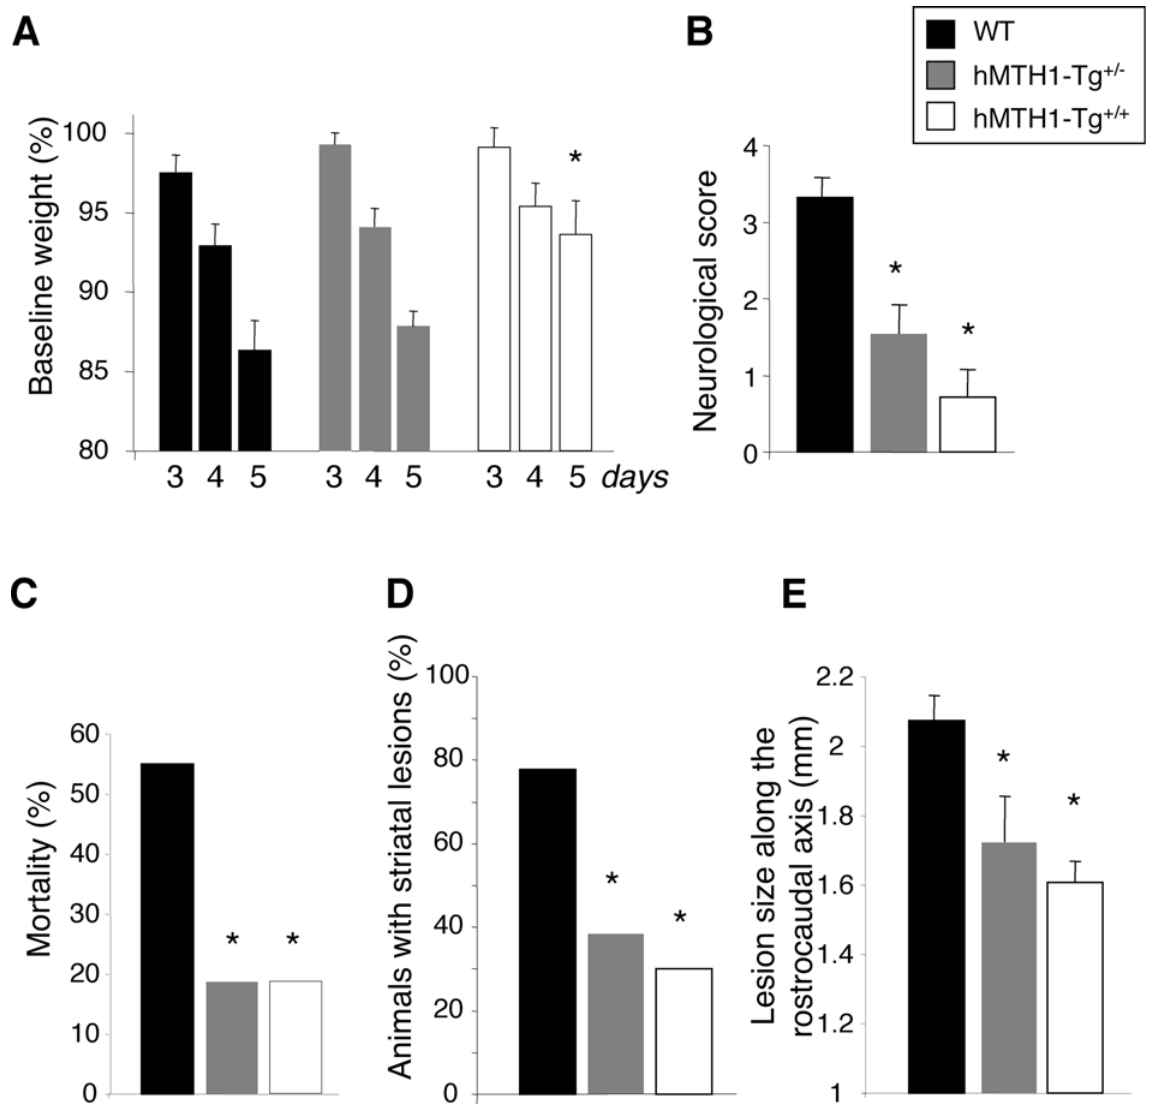
Figure 5. 3-NP-induced toxicity in wild-type and hMTH1-Tg + / 2 and hMTH1-Tg + / + transgenic mice. Groups of wild-type (n=20), hMTH1- Tg + / 2 (n=16) and hMTH1-Tg + / + (n=16) mice were injected i.p. twice daily for 5 days with 60 mg/kg 3-NP. Wild-type (black bars), hMTH1-Tg + / 2 (grey bars) and hMTH1-Tg + / + (white bars). (A) Weight loss. Body weight, measured immediately before the first injection on the indicated days, is expressed as a percentage of the pretreated body weight. (B) Motor impairment. Mice were monitored twice a day for dystonia and/or gait abnormalities. Neurological score was as follows: intermittent dystonia of one hindlimb: 1; intermittent dystonia of two hindlimbs: 2; permanent dystonia of hindimbs: 3; uncoordinated and wobbling gait or recumbency: 3; near death recumbency: 4. For each animal, the highest neurological score reached at any time of the observation period was considered. Values are mean 6 standard errors. (C) Cumulative mortality. The non-surviving fraction at the end of 5-day treatment is expressed as a percentage of starting total. (D) Striatal lesion formation. The percentage of animals with detectable post- mortem striatal lesions is shown. (E) Size of striatal lesions. Postmortem measurements of striatal lesions along the rostrocaudal axis. The asterisks indicate a P , 0.05 vs wild-type according to One-way Anova and Tukey multiple comparison post-hoc test for panels A, B and E and to x 2 test for panels C and D.